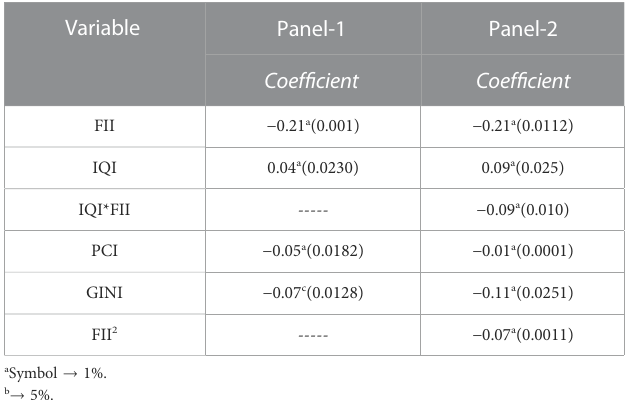
TABLE 5 Driscoll – Kraay fi xed-effect estimation. Panel-1